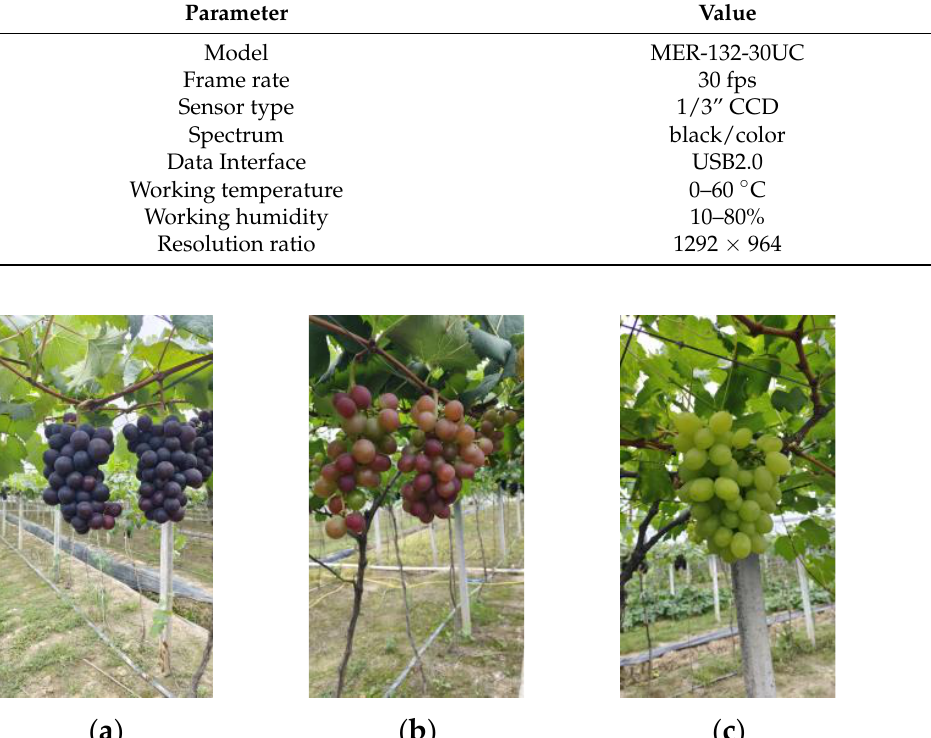
Figure 2. Three grape varieties: ( a ) Kyoho; ( b ) Red Fuji; ( c ) Victoria. Table 3. Number of grapes images in different collection conditions. (“√” indicates “yes”; “×” indi- cates “no”) .